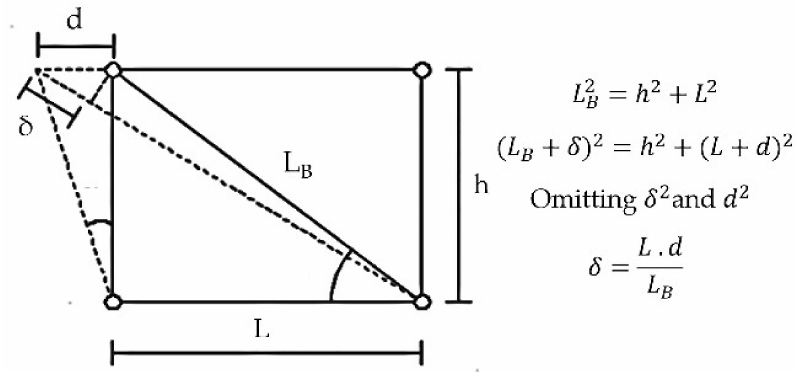
Figure 5. Loading protocol.